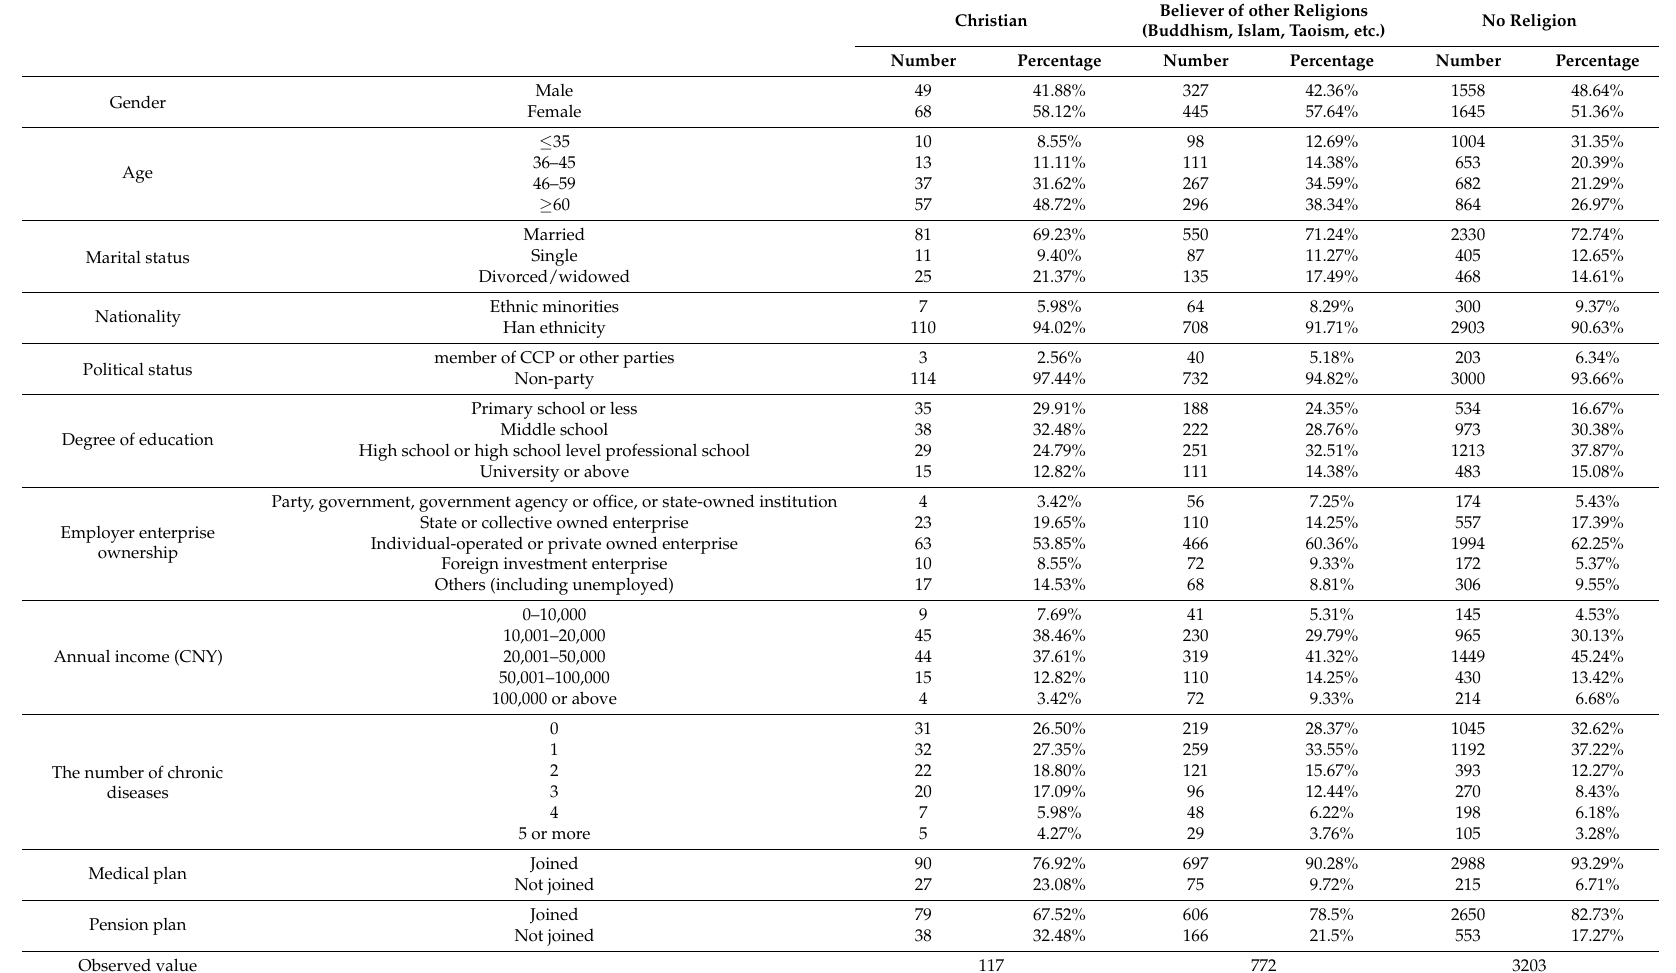
Table 2. Comparison of Christian, other religions, and non-religious urban